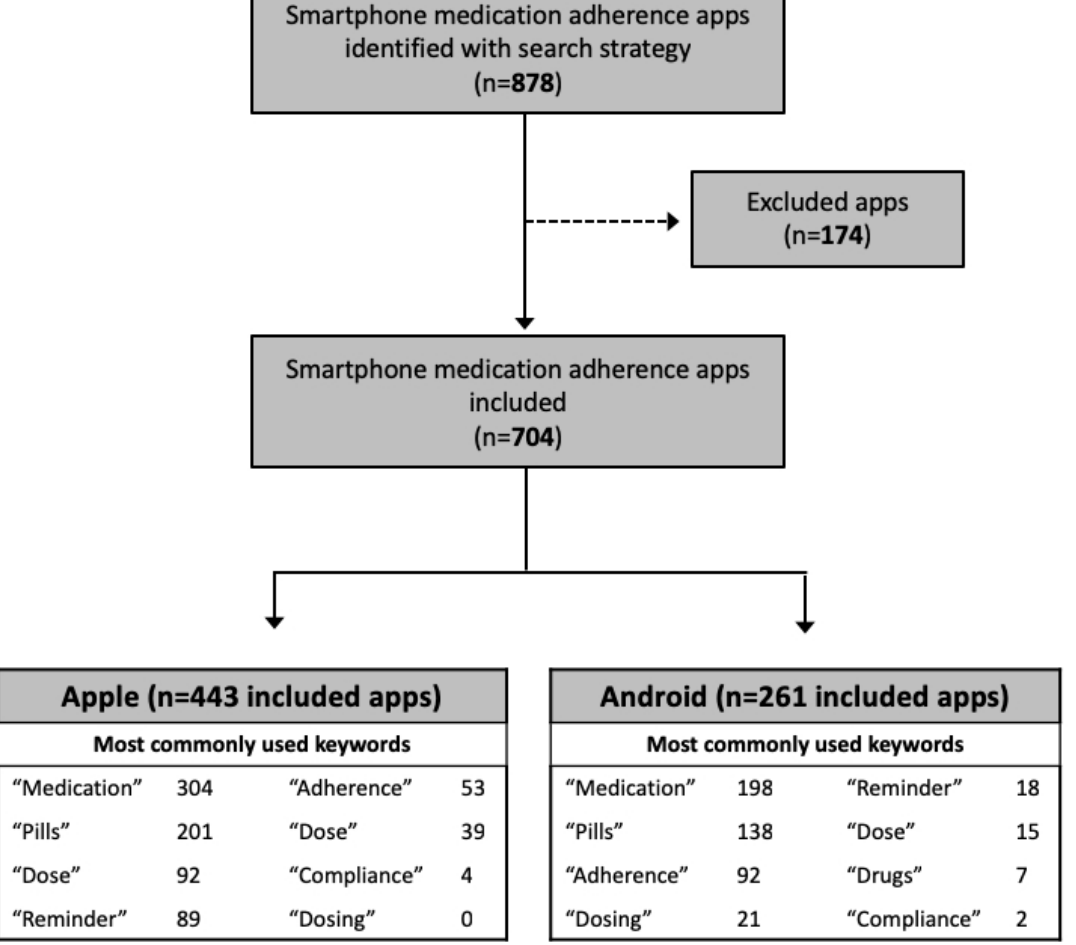
Figure 1. Flow of smartphone medication adherence apps included and most commonly used keywords (does not add up to number of apps since multiple keywords may be used to identify an